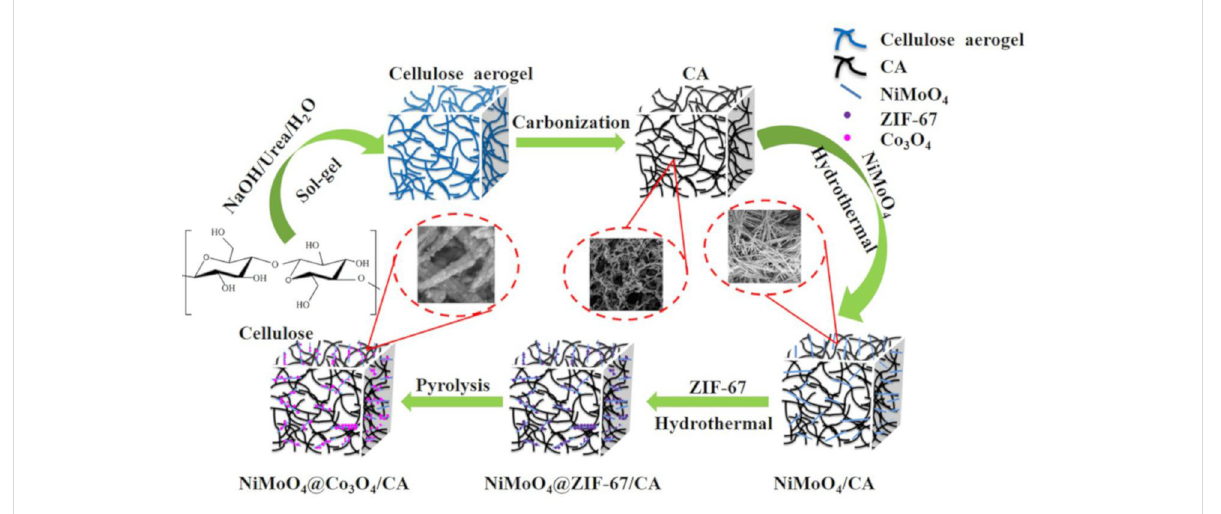
Figure 1: Schematic illustration of the preparation of the uniform hierarchical NiMoO 4 @Co 3 O 4 /CA sample.